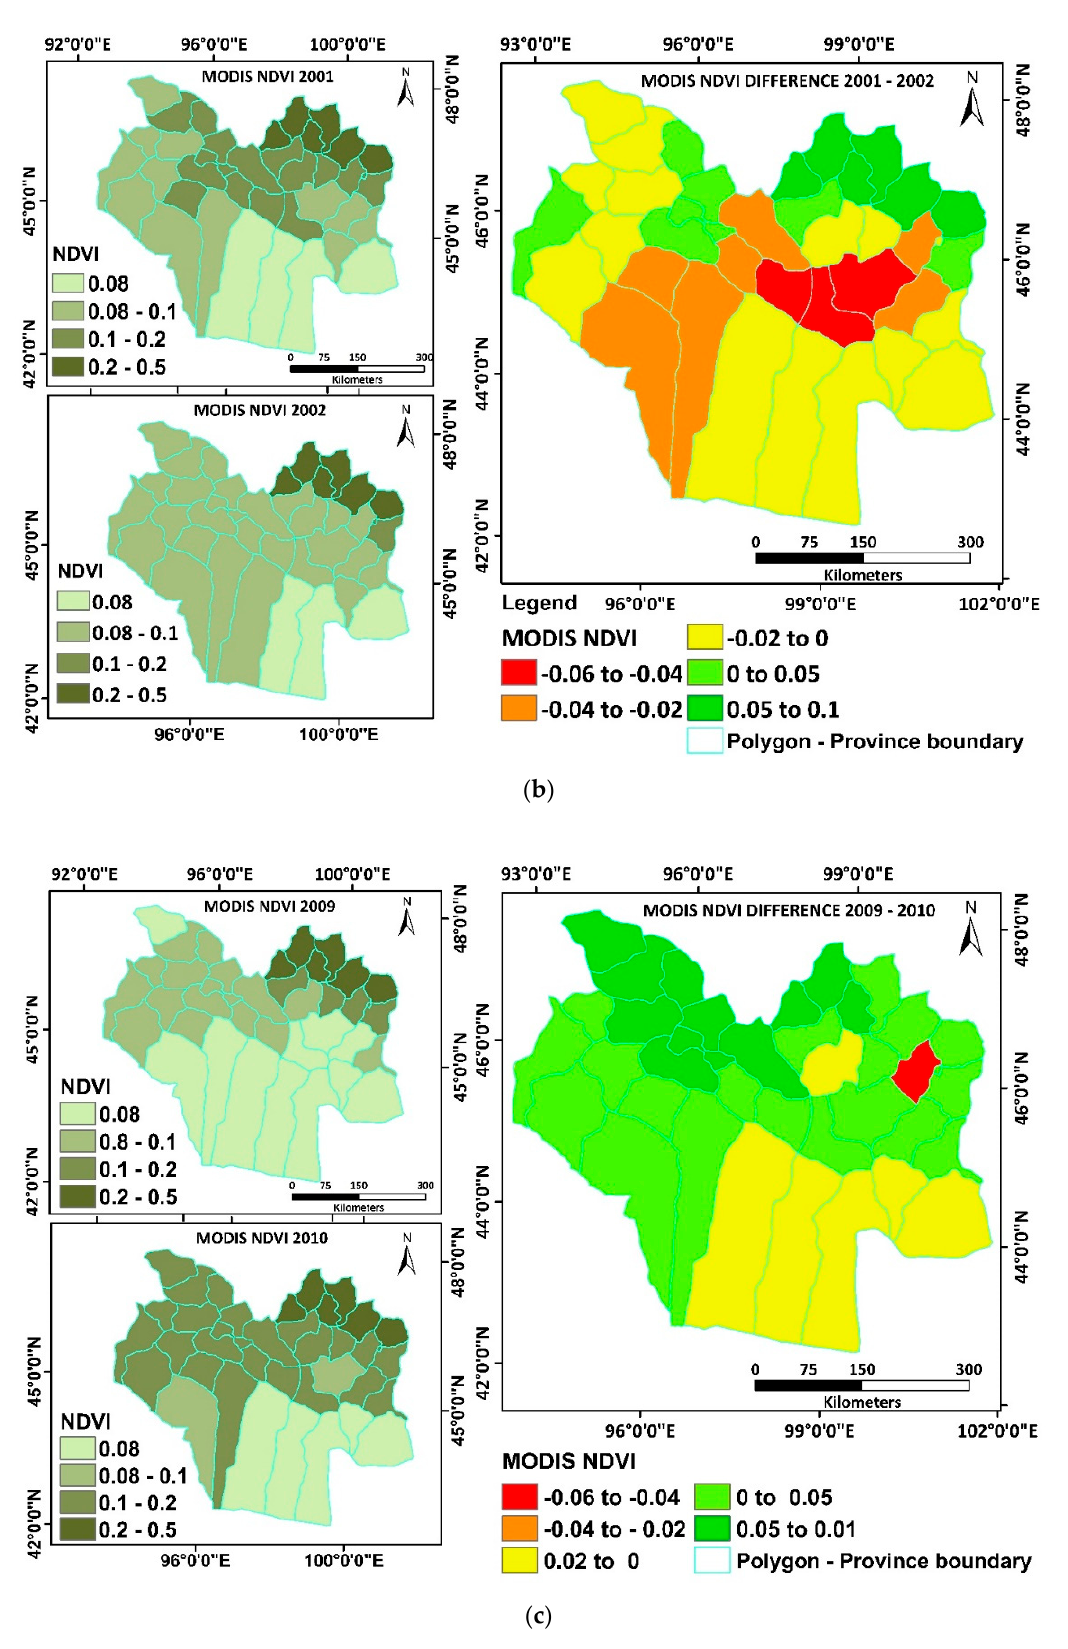
Figure 7. Spatial patterns of MODIS NDVI after dzud events ( a ) 2000/2001; ( b ) 2001/2002 and ( c ) 2009/2010.